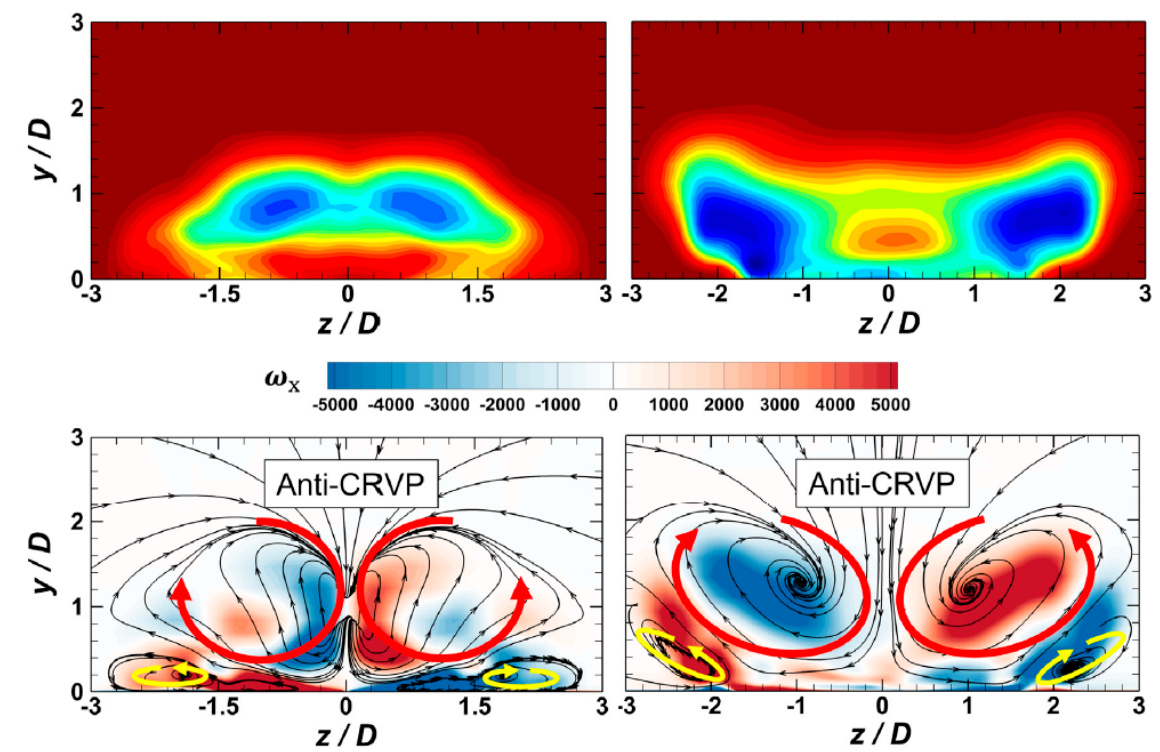
Figure 23. Sweeping effects from oscillating jets are demonstrated with two different SJ configura- tions [133].